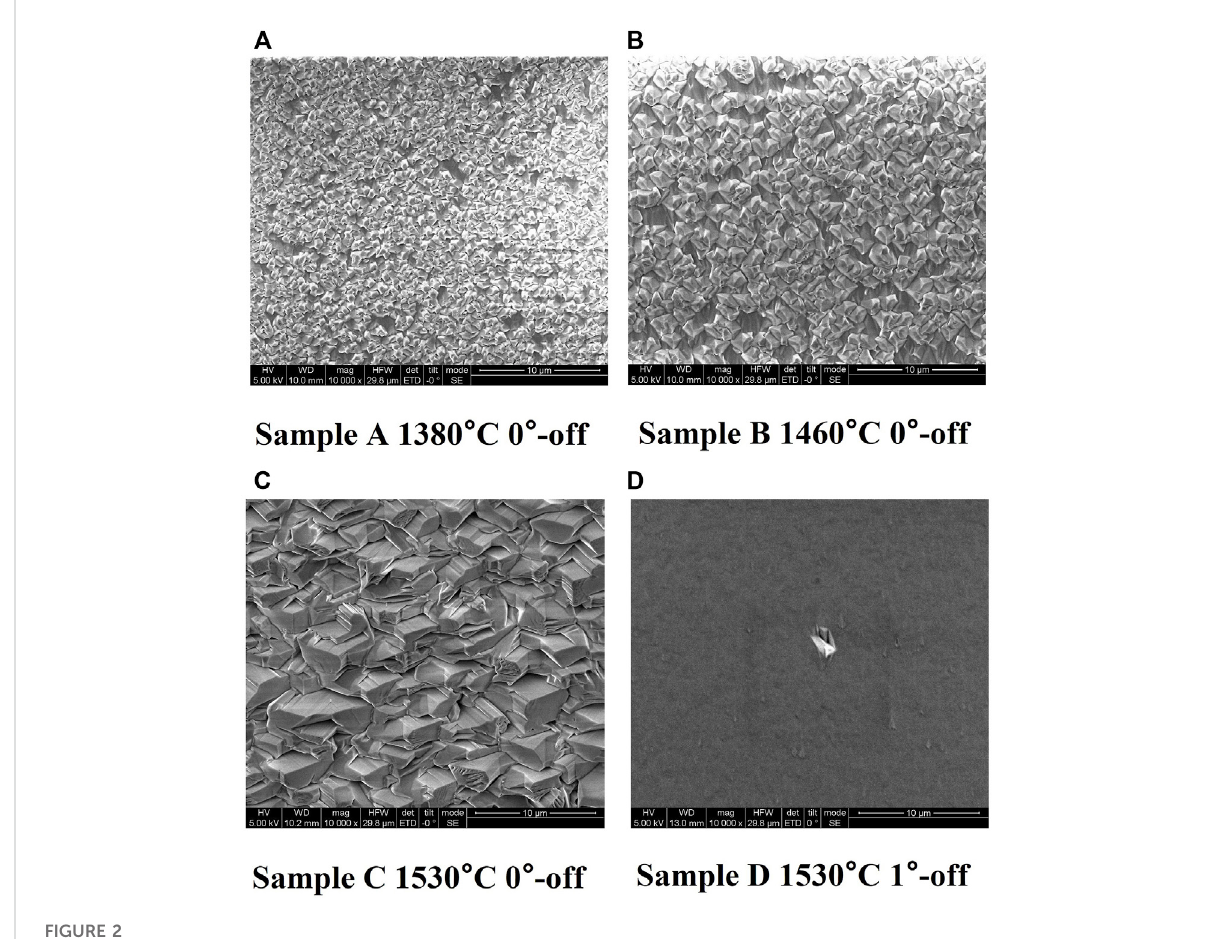
FIGURE 2 Surface morphology of samples (A) A, (B) B, (C) C and (D) D measured by SEM.